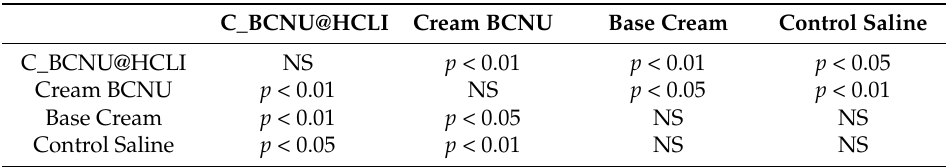
Table 8. Cox-2 expression level: the difference between the means obtained by performing the two-tailed t -Student test for independent samples (unequal variance) and confidence interval set at 95%; (TIFFalyzer).